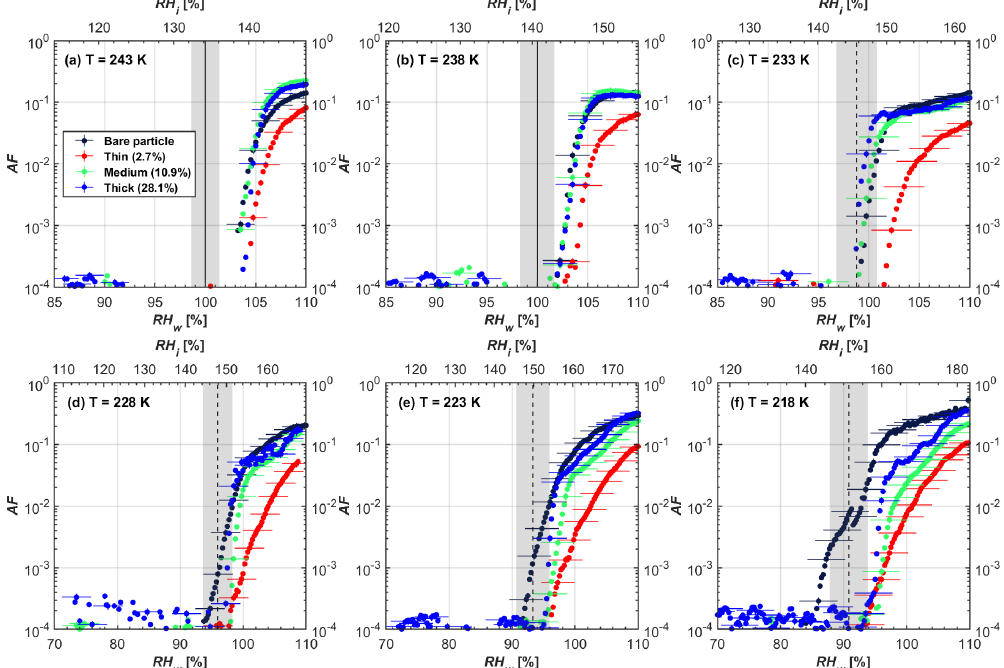
Figure 4. AF as a function of RH at the given temperatures for 200nm mCASTblack soot particles. Black solid lines represent water satura- tion conditions according to Murphy and Koop (2005). Black dashed lines denote the expected RH values for solution droplet homogeneous freezing at T < HNT (Koop et al., 2000). The grey-shaded area shows the possible RH variation and uncertainty in HINC for the calculated water saturation and homogeneous freezing conditions. The percentages represent the H 2 SO 4 coating